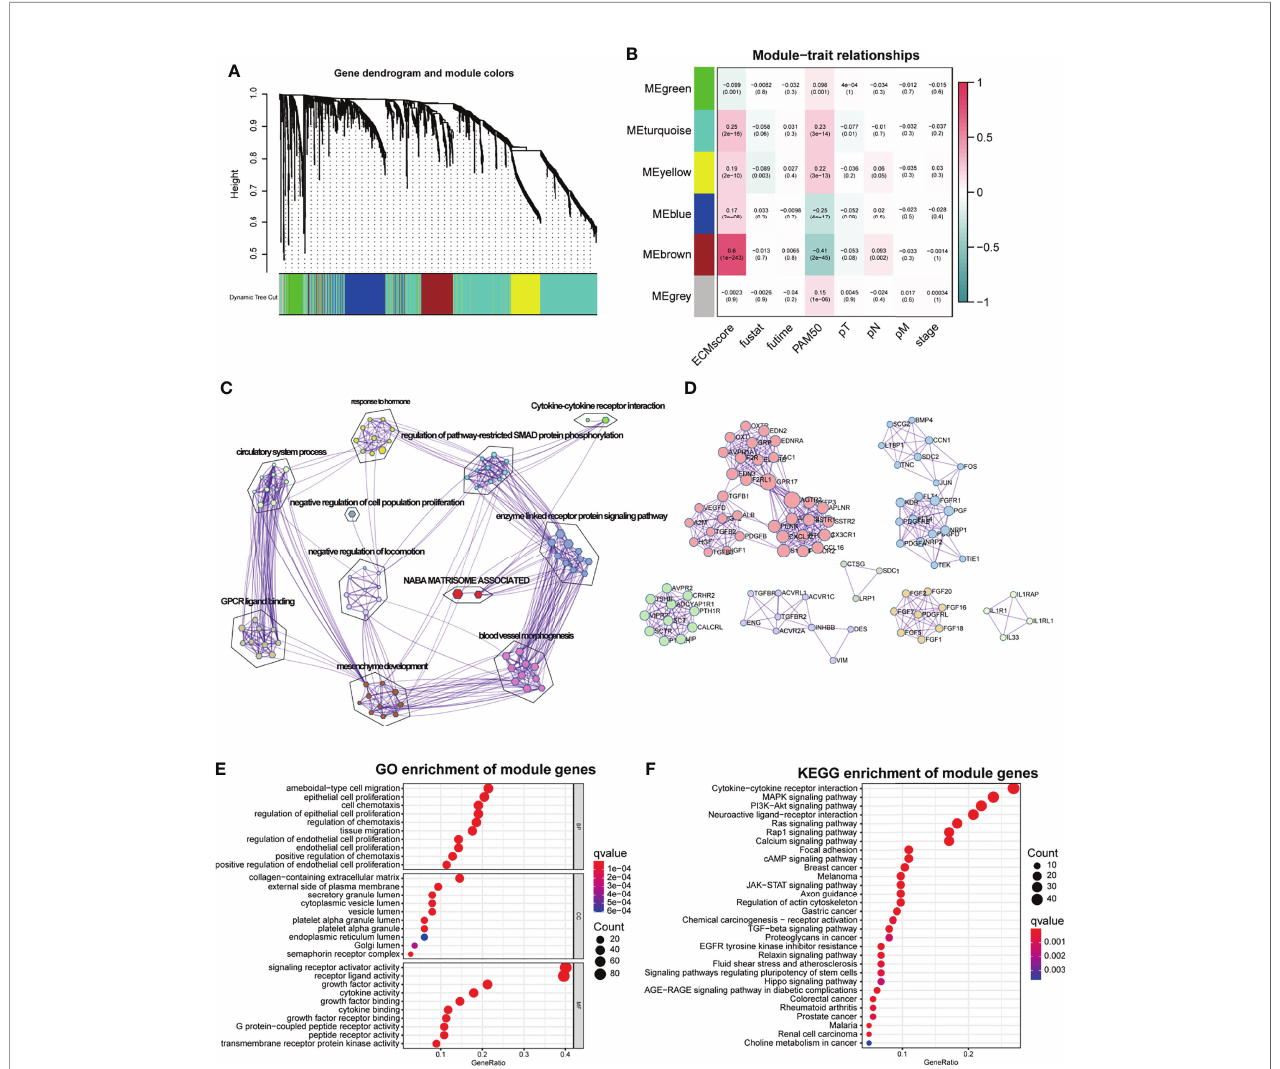
FIGURE 1 | WGCNA for the ECM-related immune genes. (A) Cluster dendrogram generating gene modules. (B) Correlation analysis of modules and ECM score, and other clinical information. (C) Metascape for the functional annotation of the genes in the Brown module. (D) PPI network for signi fi cant protein – protein interactions among genes in the Brown module. (E) GO functional enrichment analysis of genes in the Brown module. (F) KEGG functional enrichment analysis of genes in the Brown module.